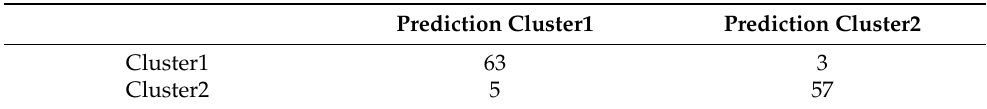
Table 2. Classifier confusion matrix based on the Bayesian